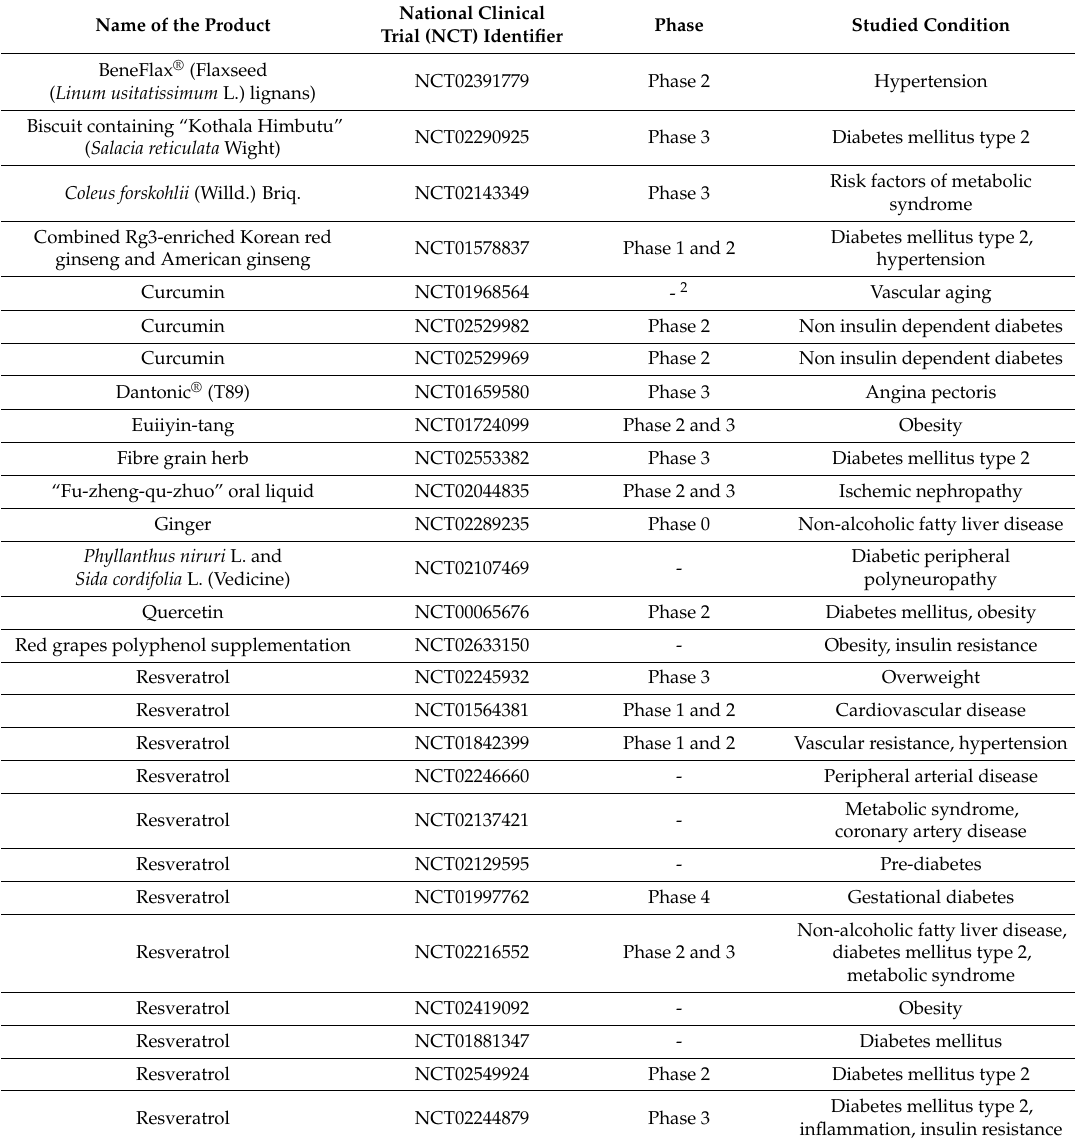
Table 2. Herbal extracts and natural products in recruiting clinical trials targeting indications related to metabolic or cardiovascular diseases 1